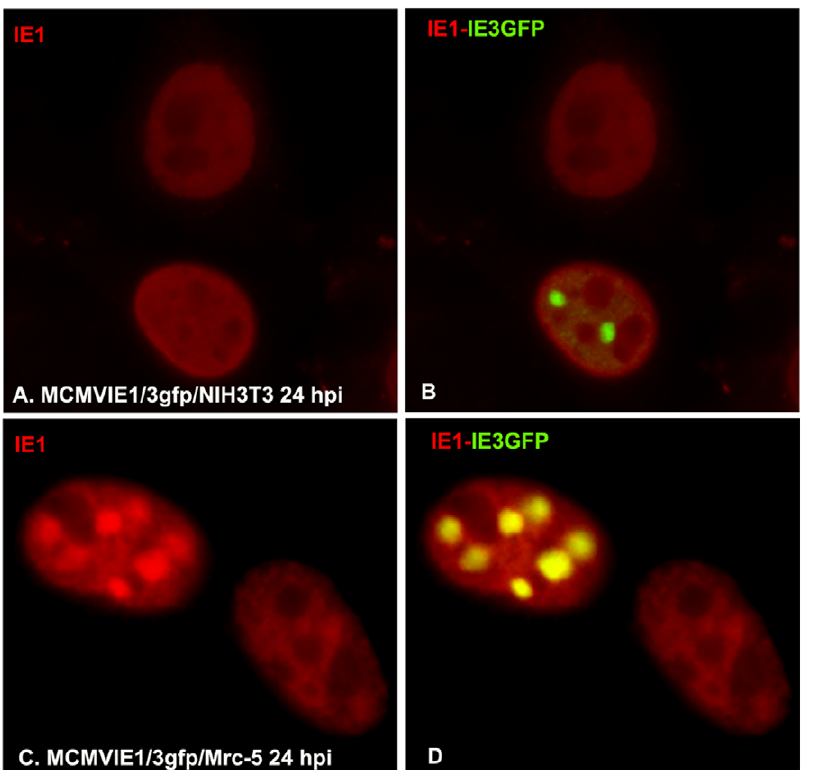
Figure 3. Immunofluorescent assay to show IE1 and IE3 in murine cytomegalovirus-infected human and mouse cells. Upper: MCMVIE1/3gfp-infected NIH3T3 cells to show distribution of IE1 (left) and IE1_IE3 (right). Lower: MCMVIE1/3gfp-infected Mrc-5 cells to show distribution of IE1 (left) and IE1_IE3 (right).